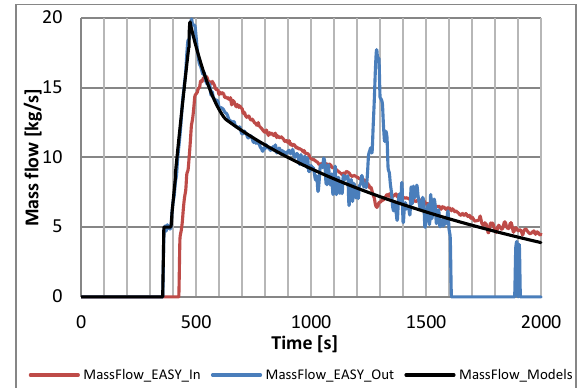
Fig. 5. Measured and modelled mass flows.